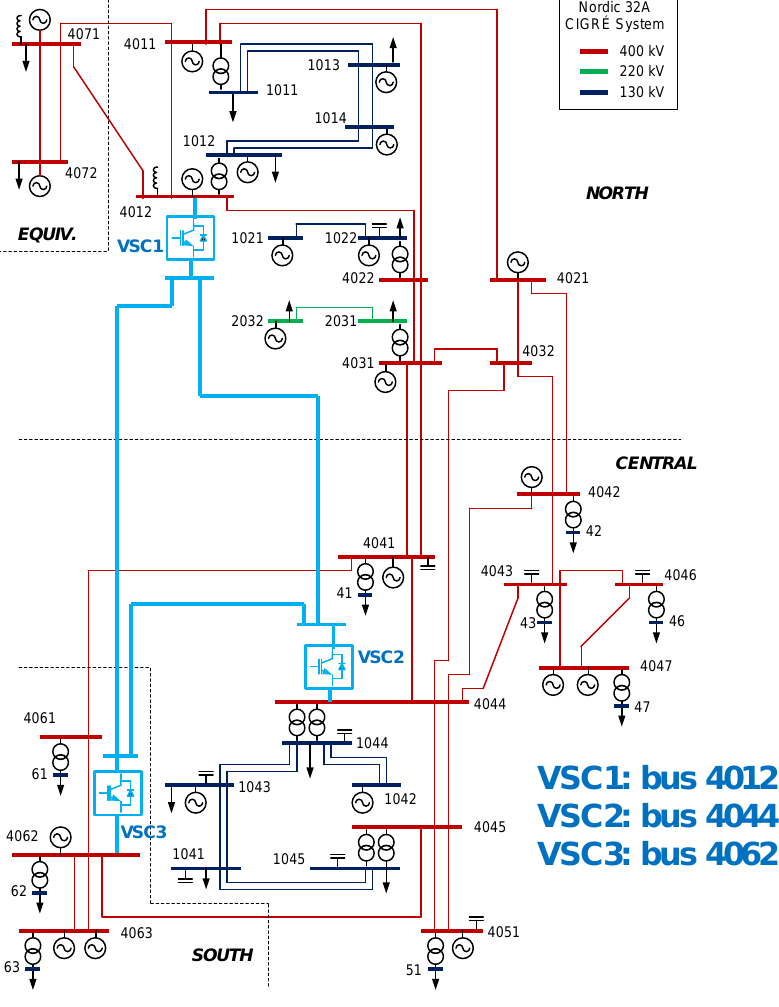
Figure 24. Cigré Nordic 32A system with an embedded VSC-MTDC